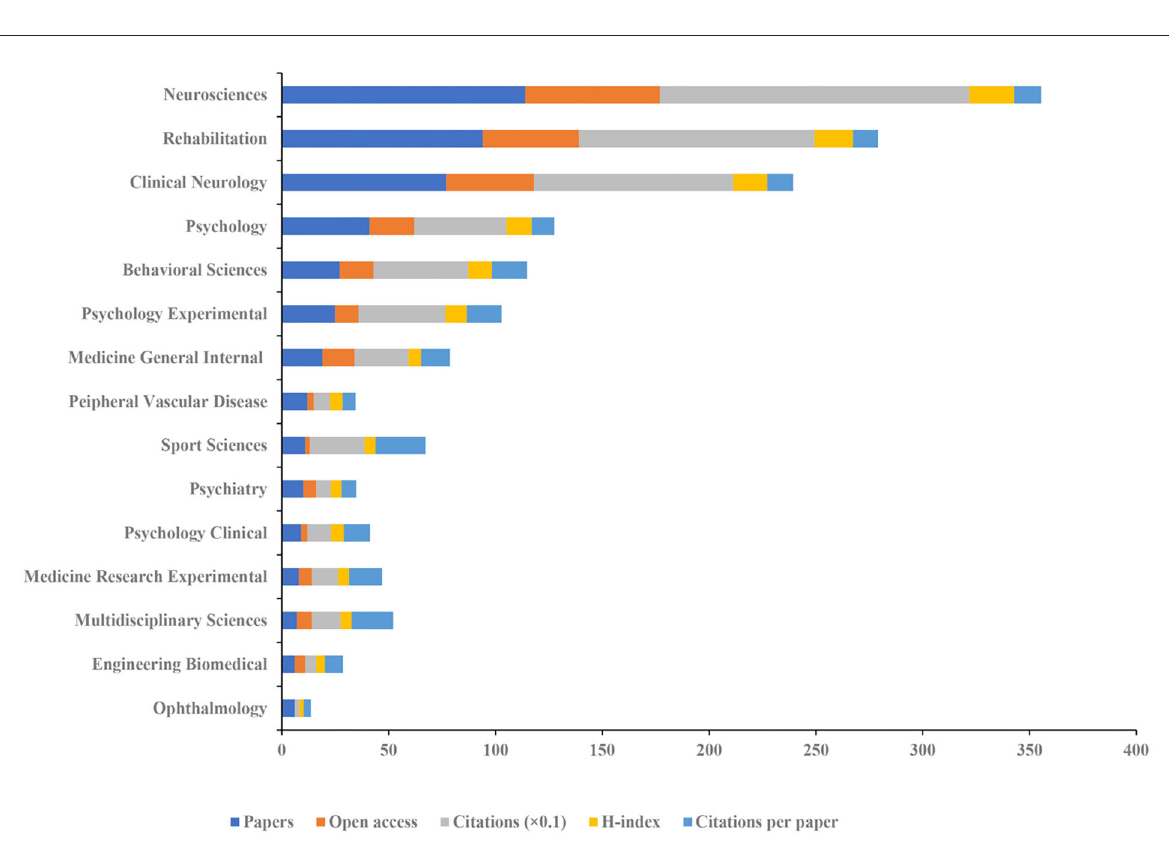
Evidence-Based Cognitive Rehabilitation: Systematic Review of the Literature From 2009 Through 2014” was published in 2013